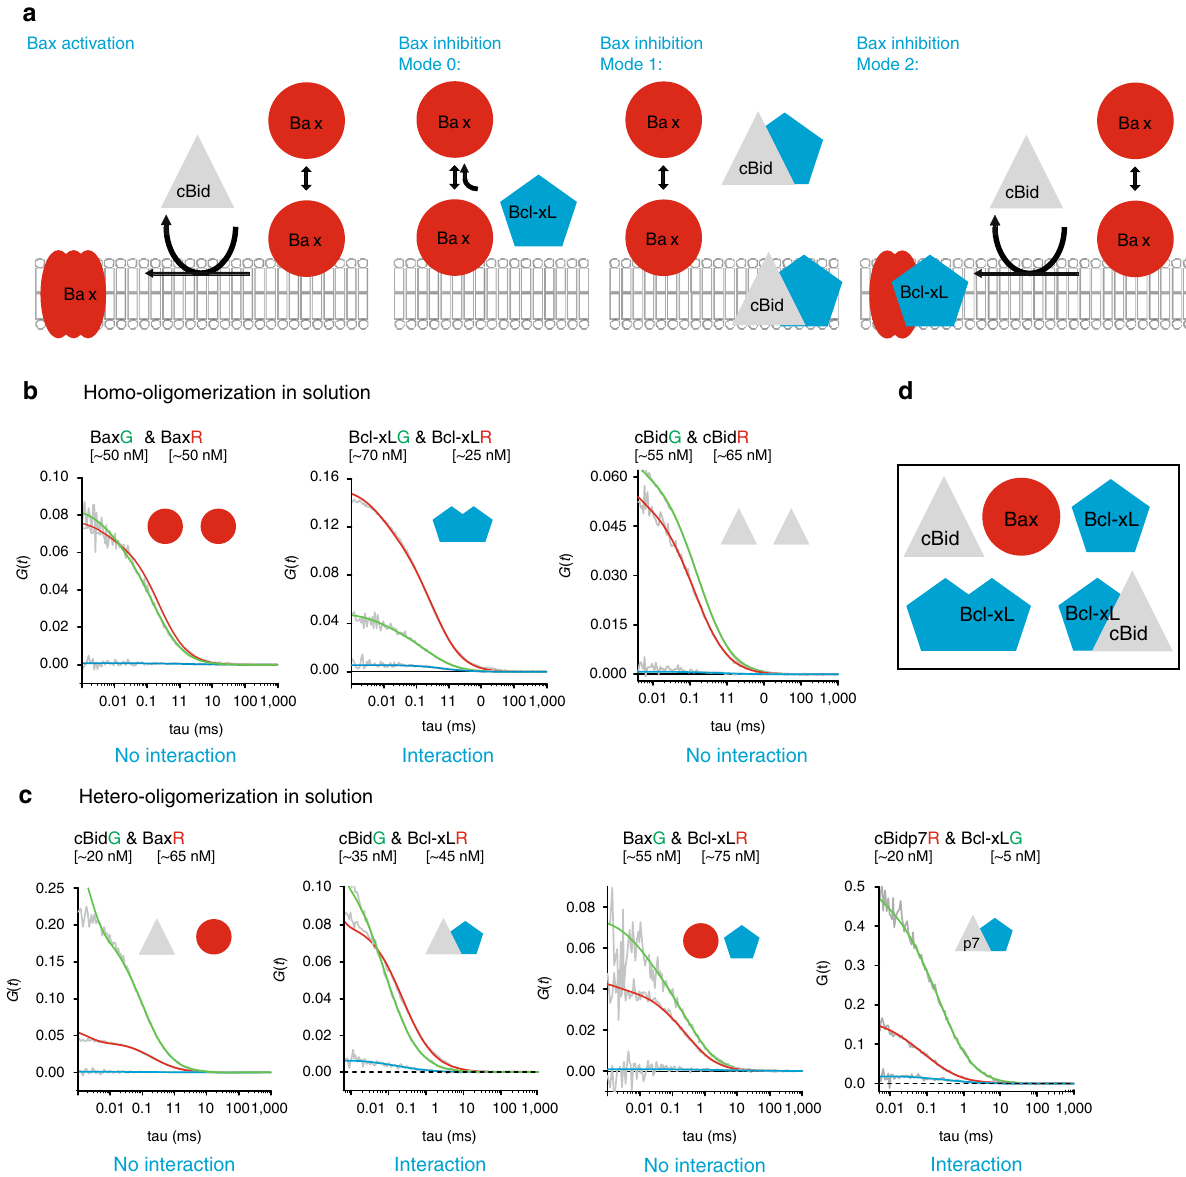
Fig. 1 Analysis of interactions between cBid, Bax, and Bcl-xL in solution. a Representation of current models on Bax activation and inhibition by cBid and Bcl-xL. b , c Representative FCCS graphs of cBid, Bax, and Bcl-xL homo-hetero-oligomerization (B) and hetero-oligomerization in solution. For visual guidance: The amplitude of the AC curves is inversely proportional to the number of fl uorophores, whereas the amplitude of the CC curves is proportional to the number of dual-color complexes. The decay of the AC and CC curves provides quantitative information on the diffusion properties of the particles and therefore of their size. All particle concentrations calculated from FCCS measurements refer to fl uorescent particles that diffuse as a unit. Only Bcl-xL G /Bcl-xL R and cBid G /Bcl-xL R present positive CC amplitude ( blue curve ) indicative of interaction. The un fi tted AC and CC curves are shown in grey ( n ≥ 3 independent experiments), and the fi tted AC curves corresponding to the species labeled with green and red fl uorophores and shown in green and red , respectively. We studied interactions at different protein concentrations up to 200 nM. d Scheme of the fi ve different monomeric and dimeric species that can be detected in solution. FCCS fl uorescence cross correlation dimers, in line with ref. 34 . In addition, Bcl-xL interacted with cBid, as shown before 21, 32 . By using two cBid variants labeled at the N- (cBid- p7R ) or C-terminal fragment (cBid R or cBid G, ), we found that the cBid/Bcl-xL complex contained both cBid fragments. In addition, no homo-oligomerization of cBid molecules was detected. Our results show that in solution three different complexes are formed: p7/tBid, Bcl-xL/Bcl-xL, and p7/ tBid/Bcl-xL (Fig. 1d). Those complexes are potentially competing in the cytosolic environment and based on our data only Mode 1 of Bcl-xL inhibition takes place in solution.